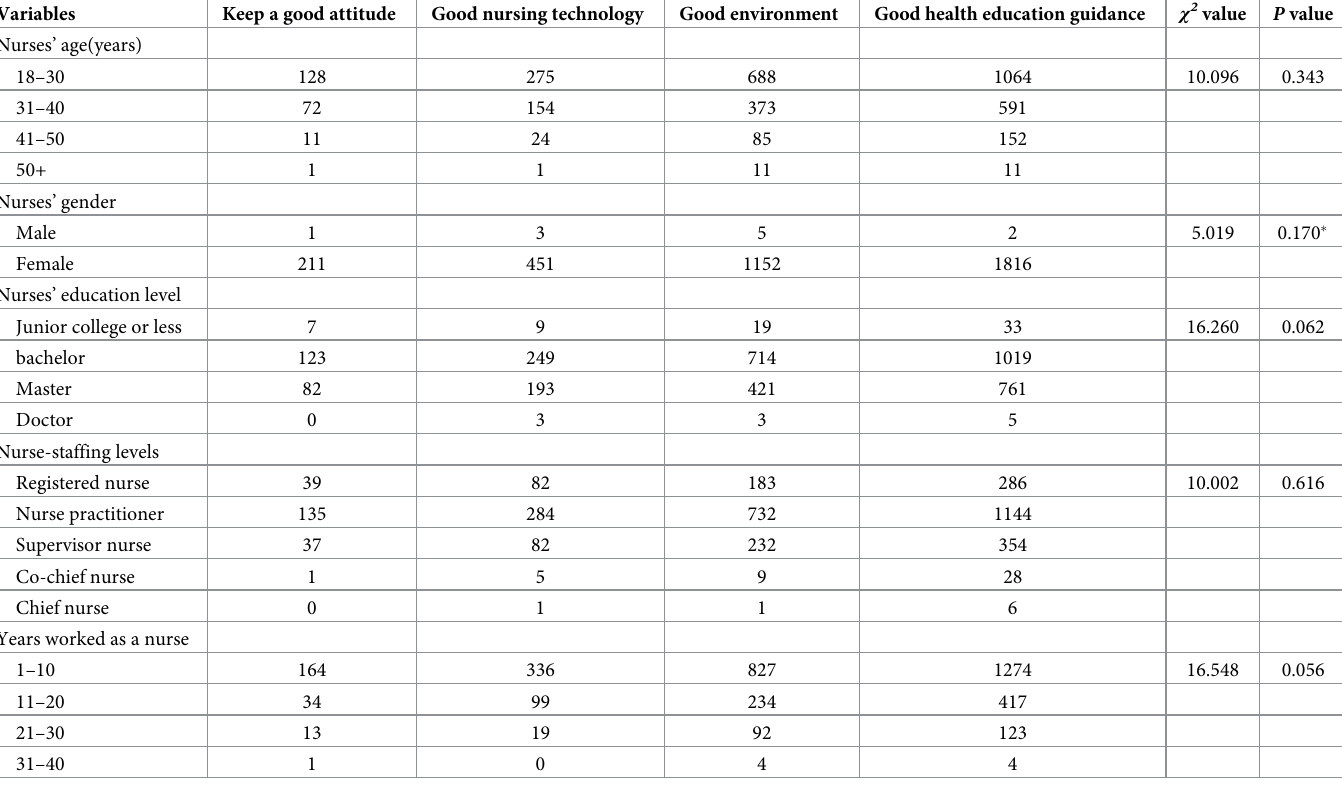
Table 2. Basic information of department and nurses in charge with patients surveyed.